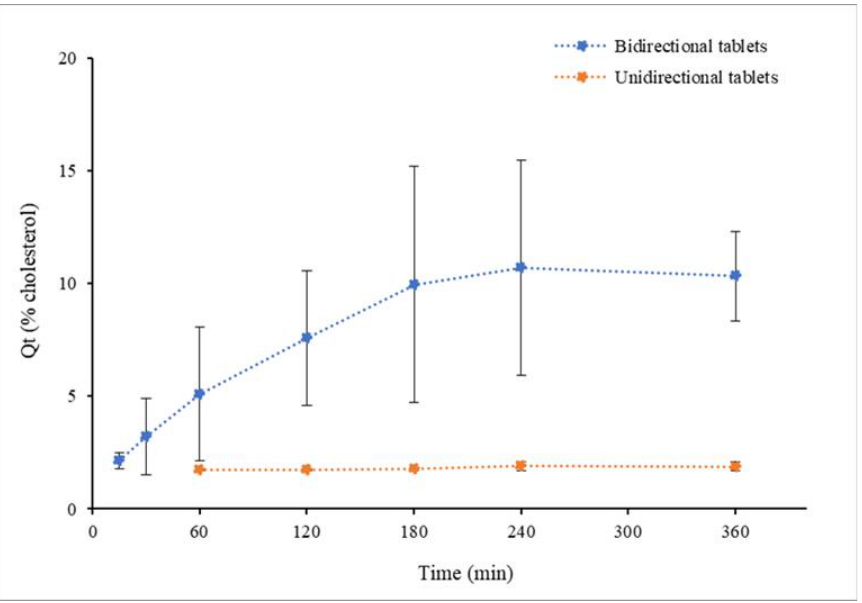
Figure 10. Liposome release from tablets measured as mean curves of cumulative percentage of cholesterol. n = 3.